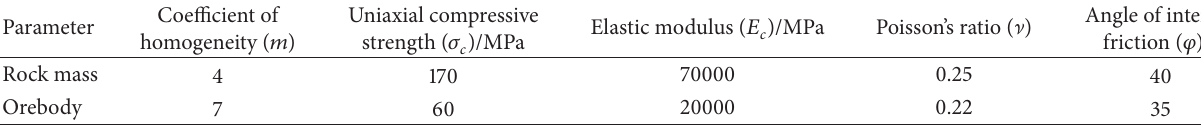
Table 1: Mechanical properties of the model.